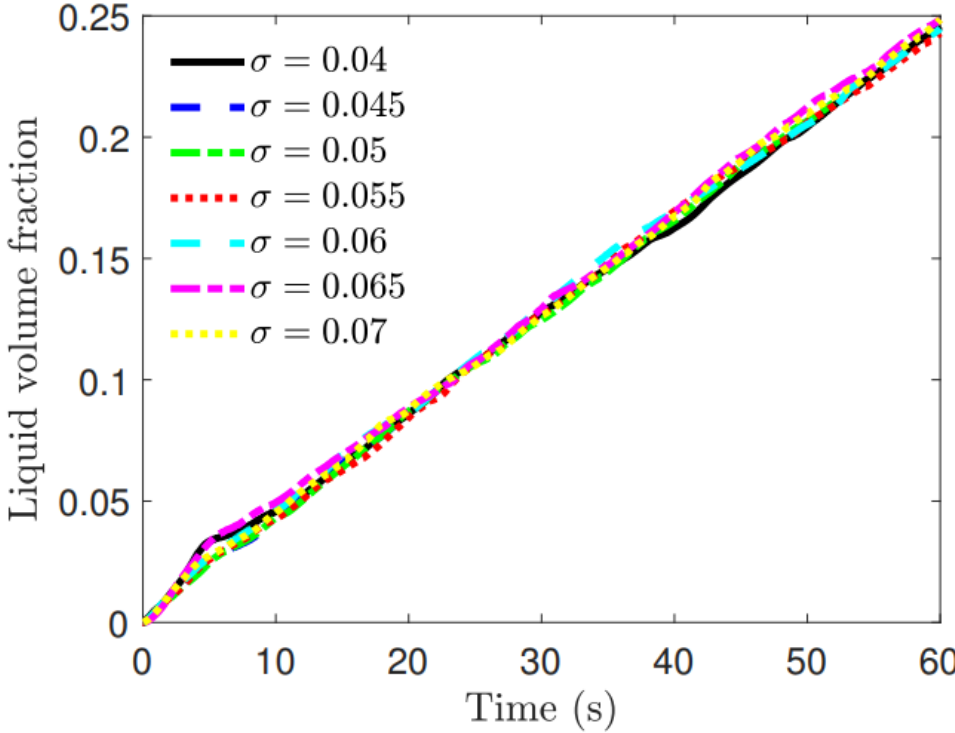
Figure 6. Evolution of the liquid volume fraction with time, where different surface tensions are adopted.